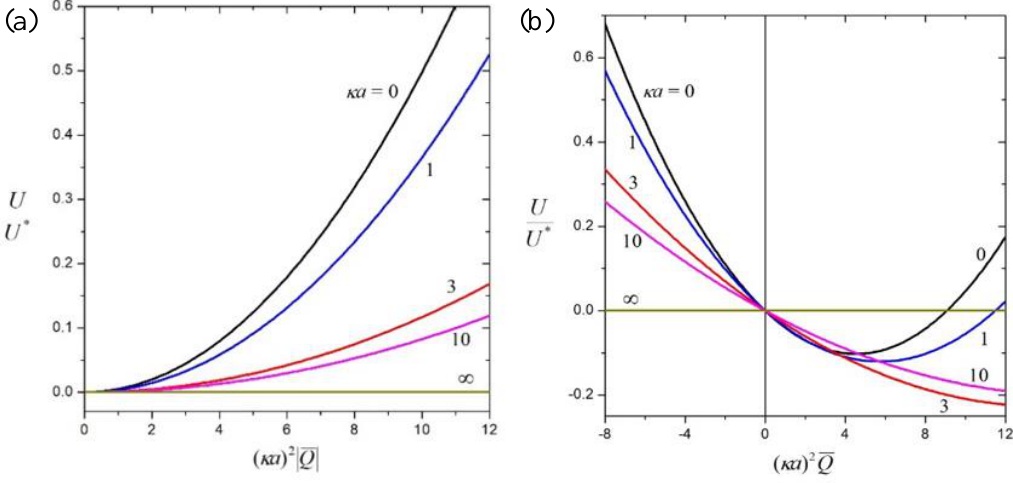
Figure 10. The reduced di ff usiophoretic mobility U / U ∗ for a suspension of soft spheres versus the dimensionless fixed charge density ( κ a ) 2 Q at σ = 0, r 0 / a = 0.5, λ a = 1, ϕ = 0.1, and various values of κ a calculated for the Happel model: ( a ) β = 0; ( b ) β = − 2 .